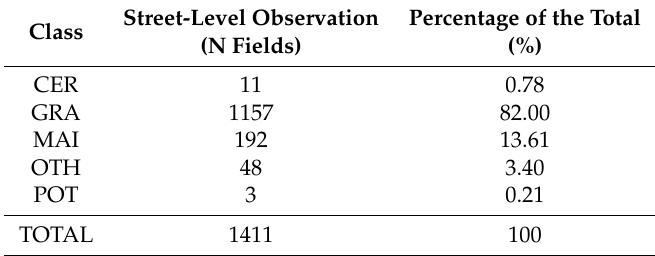
Table 6. Fields adjacent to the survey route using a 35-m buffer and summarized by class.